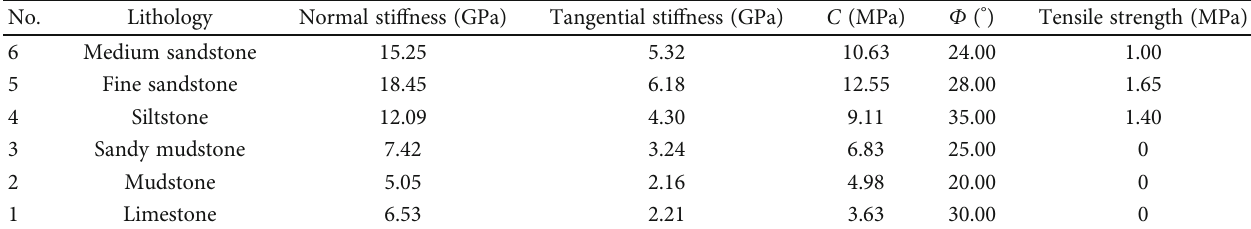
Table 3: Physical and mechanical parameters of joints between rock